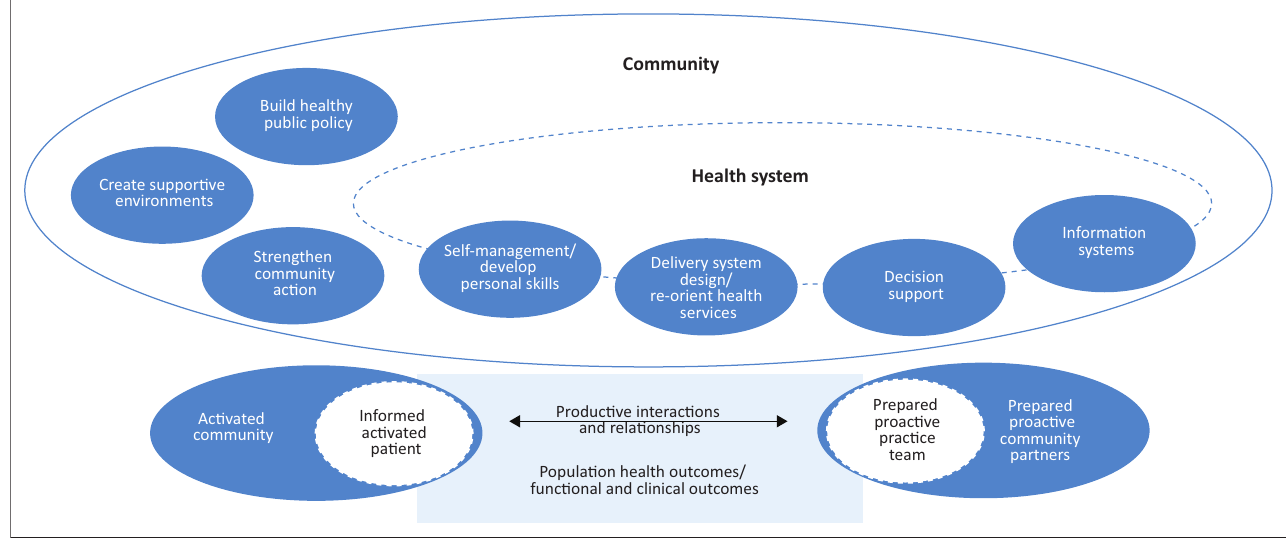
FIGURE 1: Elements of the expanded chronic care model.